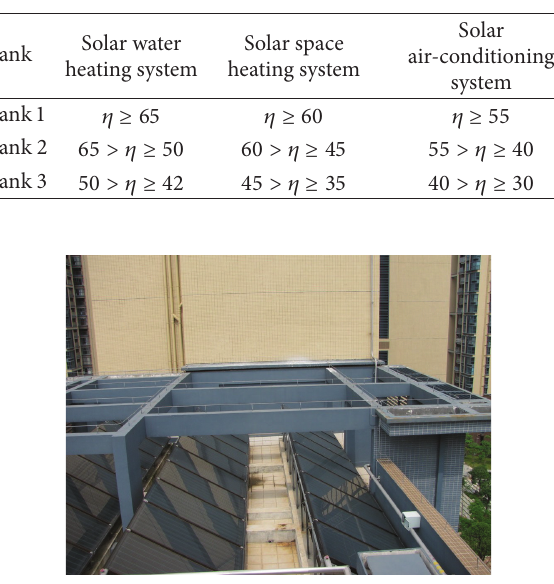
Figure 1: Flat plate solar collectors for solar water heating system in Shenzhen.